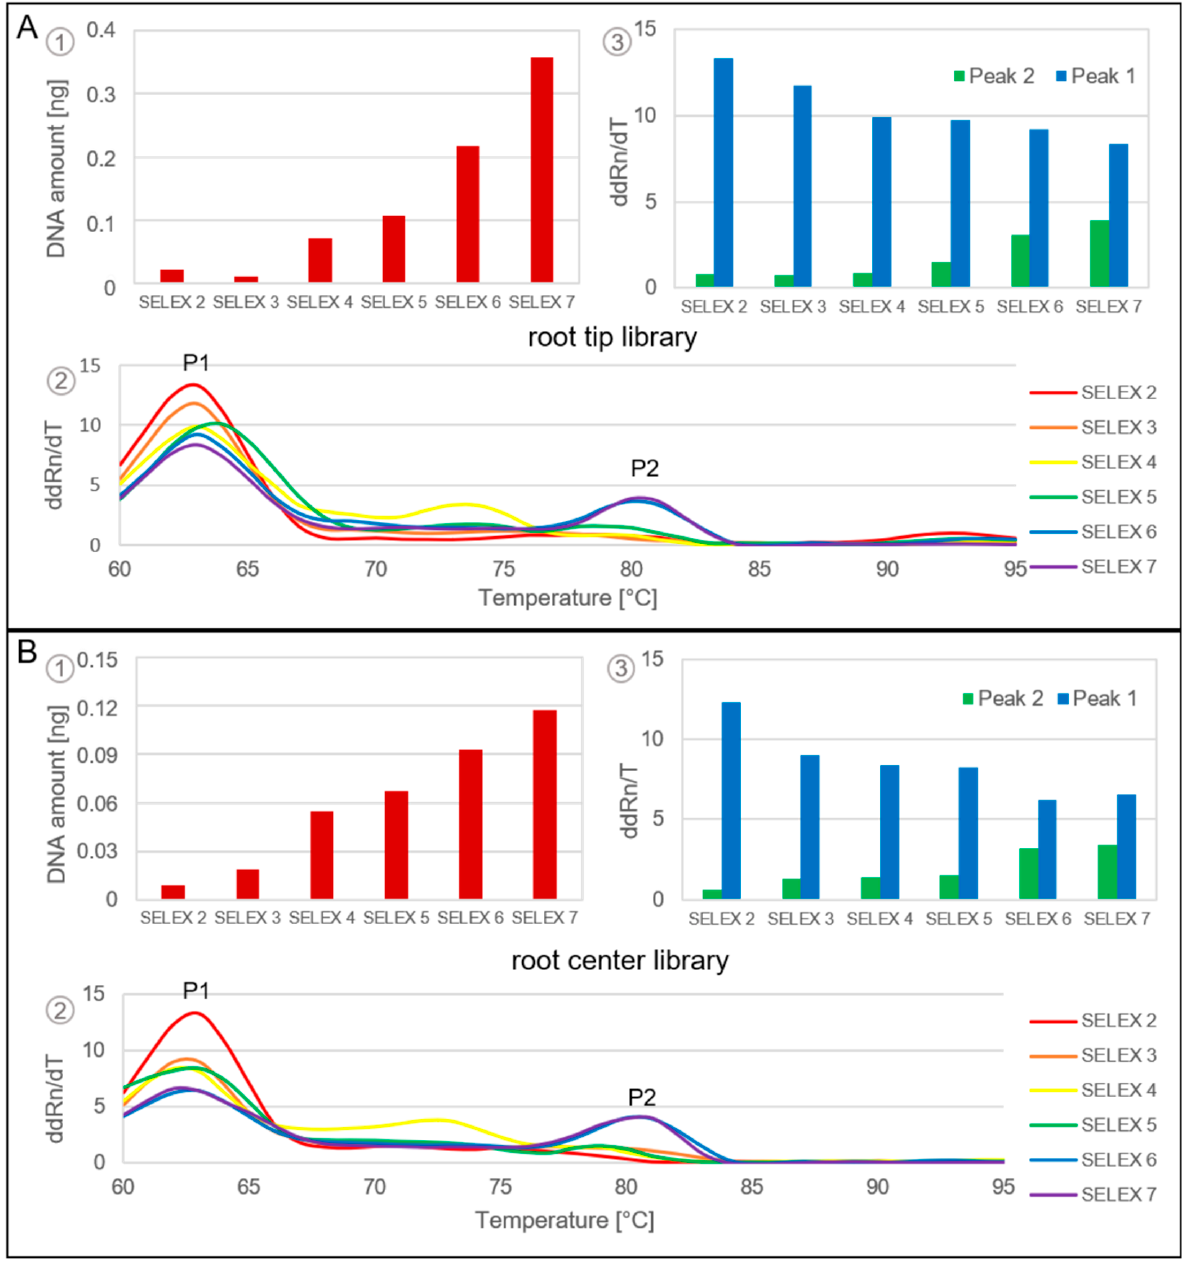
Figure 1. Real-time PCR-based evolution analysis of the ( A ) root tip and ( B ) root center aptamer libraries of rounds two through seven. (1) DNA concentrations in eluates immediately after the SELEX rounds, (2) melting curves with peak 1 (P1) and peak 2 (P2) as the two major temperature peaks observed in the experiments, and (3) peak-shifting analyses for P1 and P2. All experiments were conducted in triplicates ( N = 3) using qTOWER 3 G Touch (Analytik Jena GmbH, Jena, Ger- many).